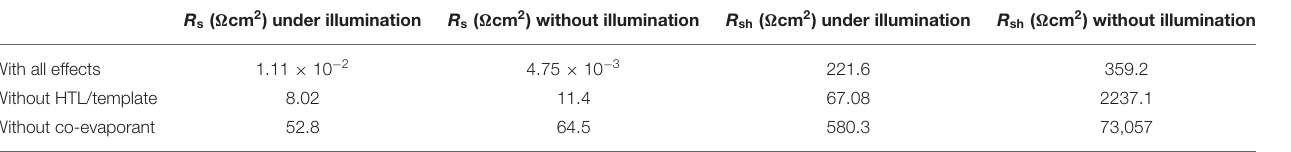
TABLE 2 | Resistances of the OPVs shown in Figure 7 . R s ( (cid:127) cm 2 ) under illumination R s ( (cid:127) cm 2 ) without